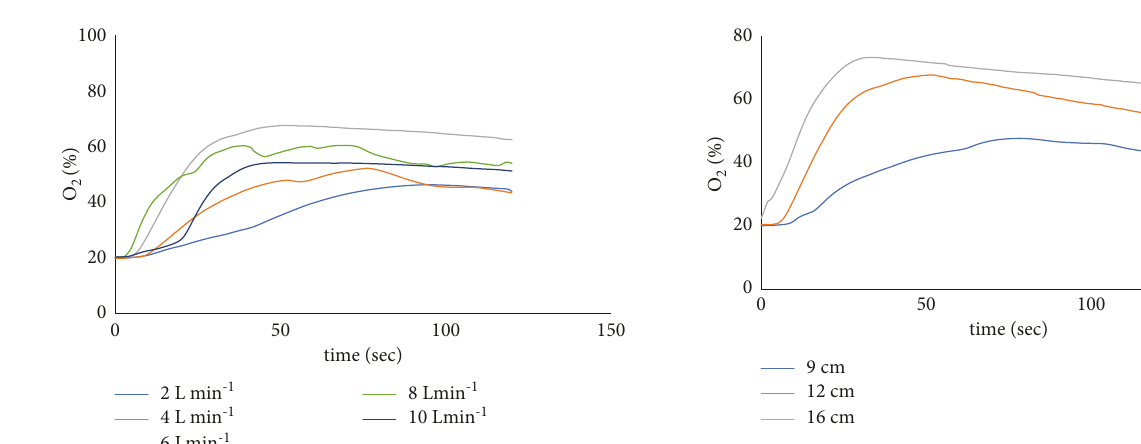
Figure 5: O 2 % as a function of time for different heights of packing;